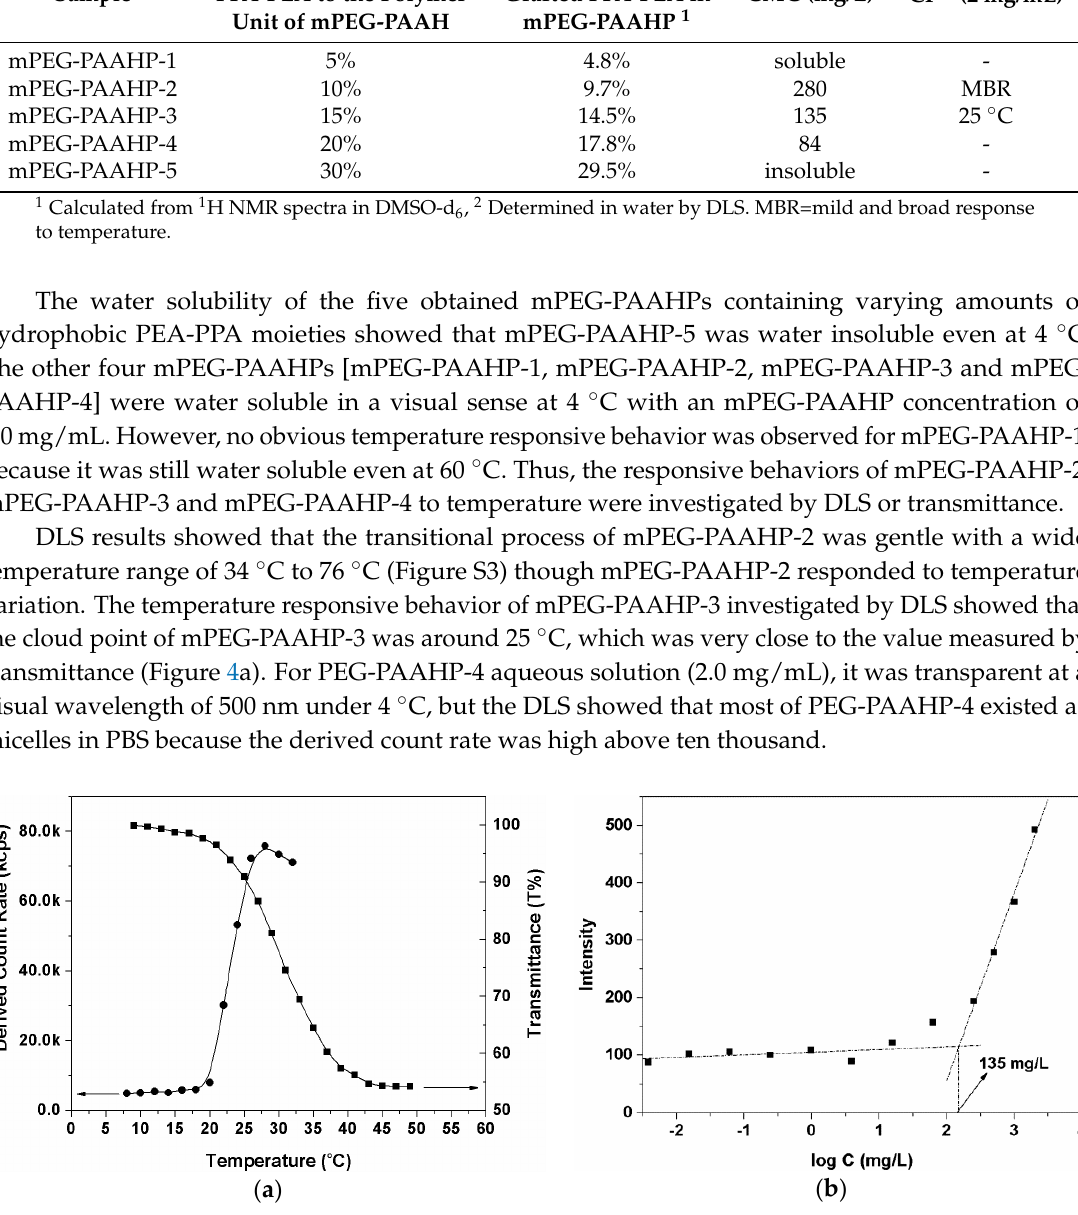
Figure 4. ( a ) The temperature responsive behavior of mPEG ‐ PAAHP ‐ 3 aqueous solution in PBS (pH = 7.4 ， 2.0 mg/mL) in the heating process measured by UV/Vis at 500 nm (square) and by DLS (circle); ( b ) The intensity of the excitation spectra at 337 nm after excitation of mPEG ‐ PAAHP ‐ 3 solutions at 390 nm as a function of logarithm of mPEG ‐ PAAHP ‐ 3 concentration. Table 1. Characterizations of mPEG ‐ PAAHPs.